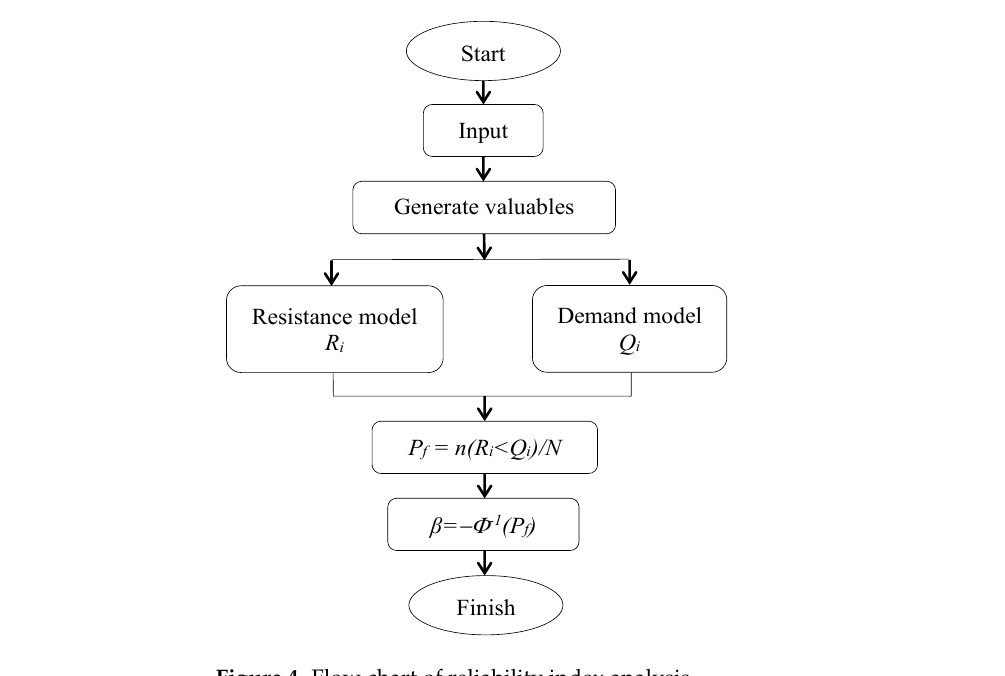
Figure 4. Flow chart of reliability index analysis.